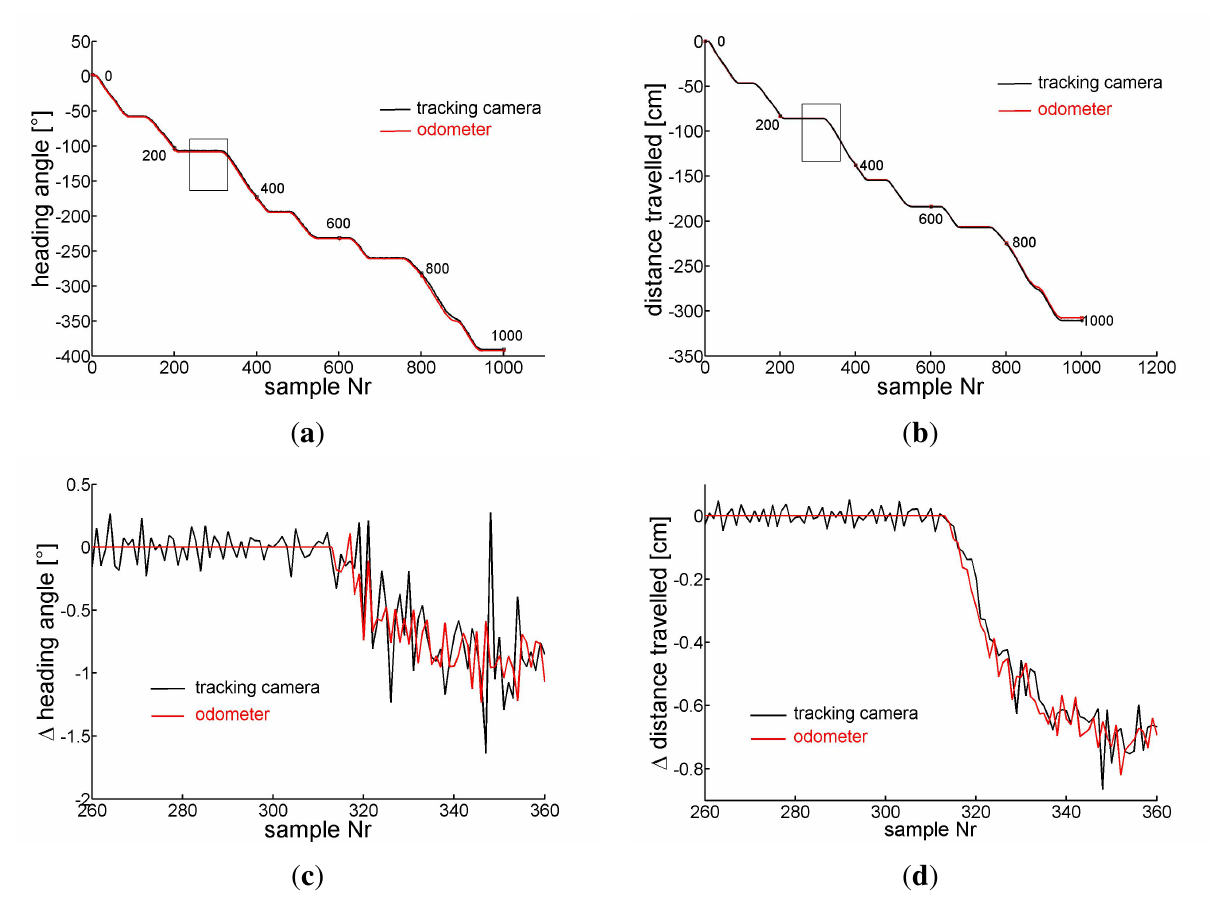
( a ) The corresponding entities, the accumulated ρ (red) (Equation (7)) and the orientation (black) of the camera image (Equation (11)). ( b ) The accumulated τ (Equation (6)) (red) and the travelled distance of the carriage taken by the camera (black) on the circle path of Figure 7. ( c ) ρ (red) and the change of the orientation of the carriage (black) between two samples, ( d ) τ and travelled distance between two samples of camera images. (c) and (d) are taken in the time intervals indicated by the rectangles in sub figures (a) and (b),